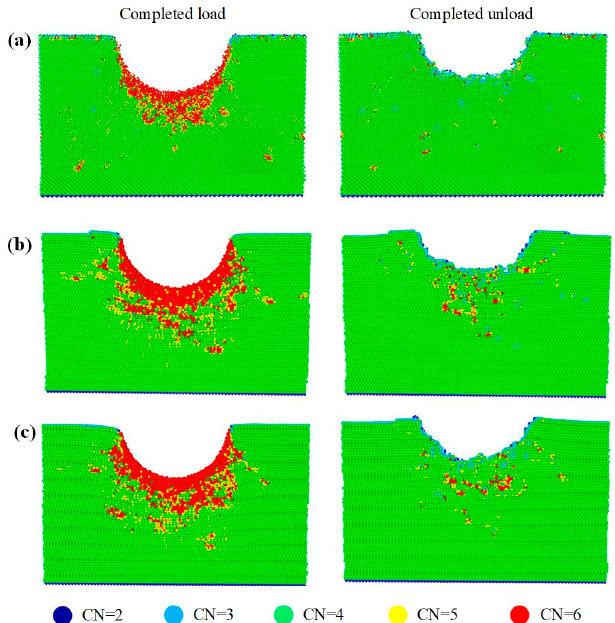
Figure 6. Coordination analysis for three types of SiC single crystal at completed load and completed unload. ( a ) 3C-SiC, ( b ) 4H-SiC, and ( c ) 6H-SiC, respectively.